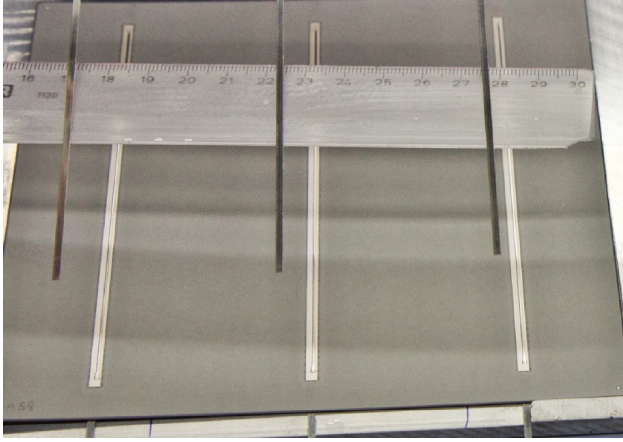
Fig. 4. Photograph of the gluing process with three busbars and ribbons.